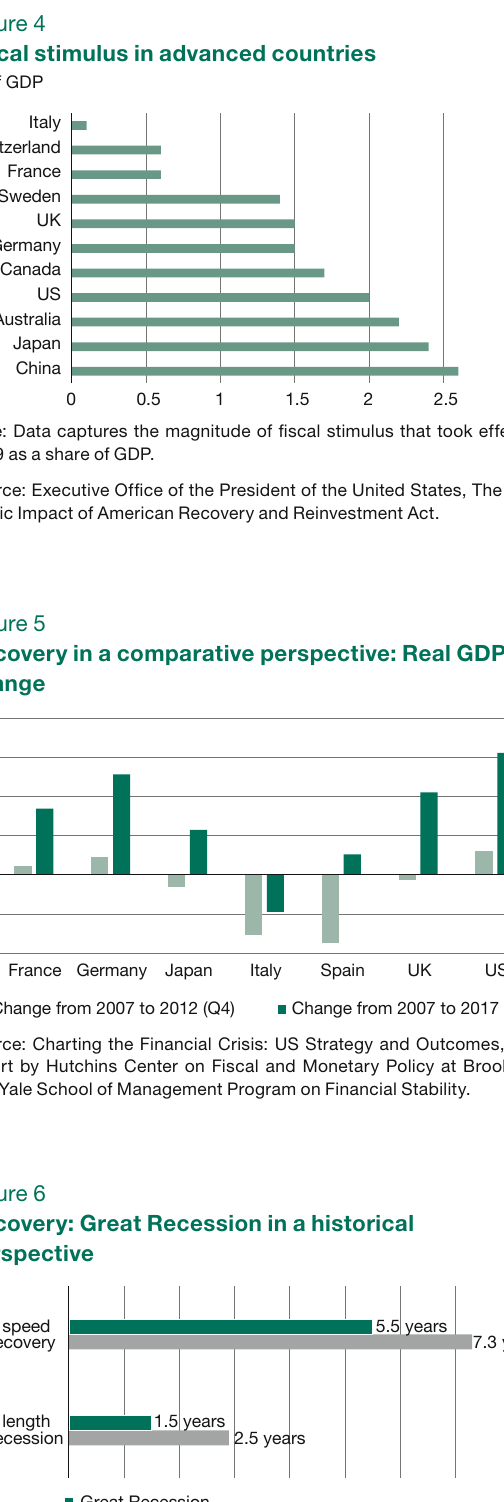
Source: Charting the Financial Crisis: US Strategy and Outcomes, joint report by Hutchins Center on Fiscal and Monetary Policy at Brookings and Yale School of Management Program on Financial